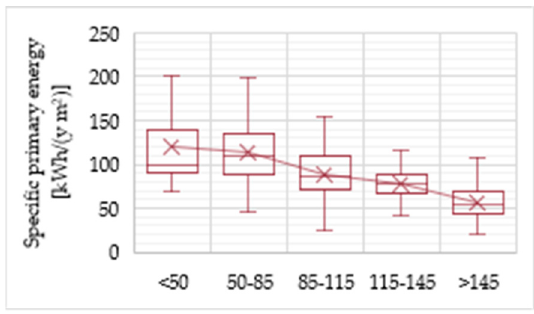
Figure 8. Specific consumption of primary energy for other services.